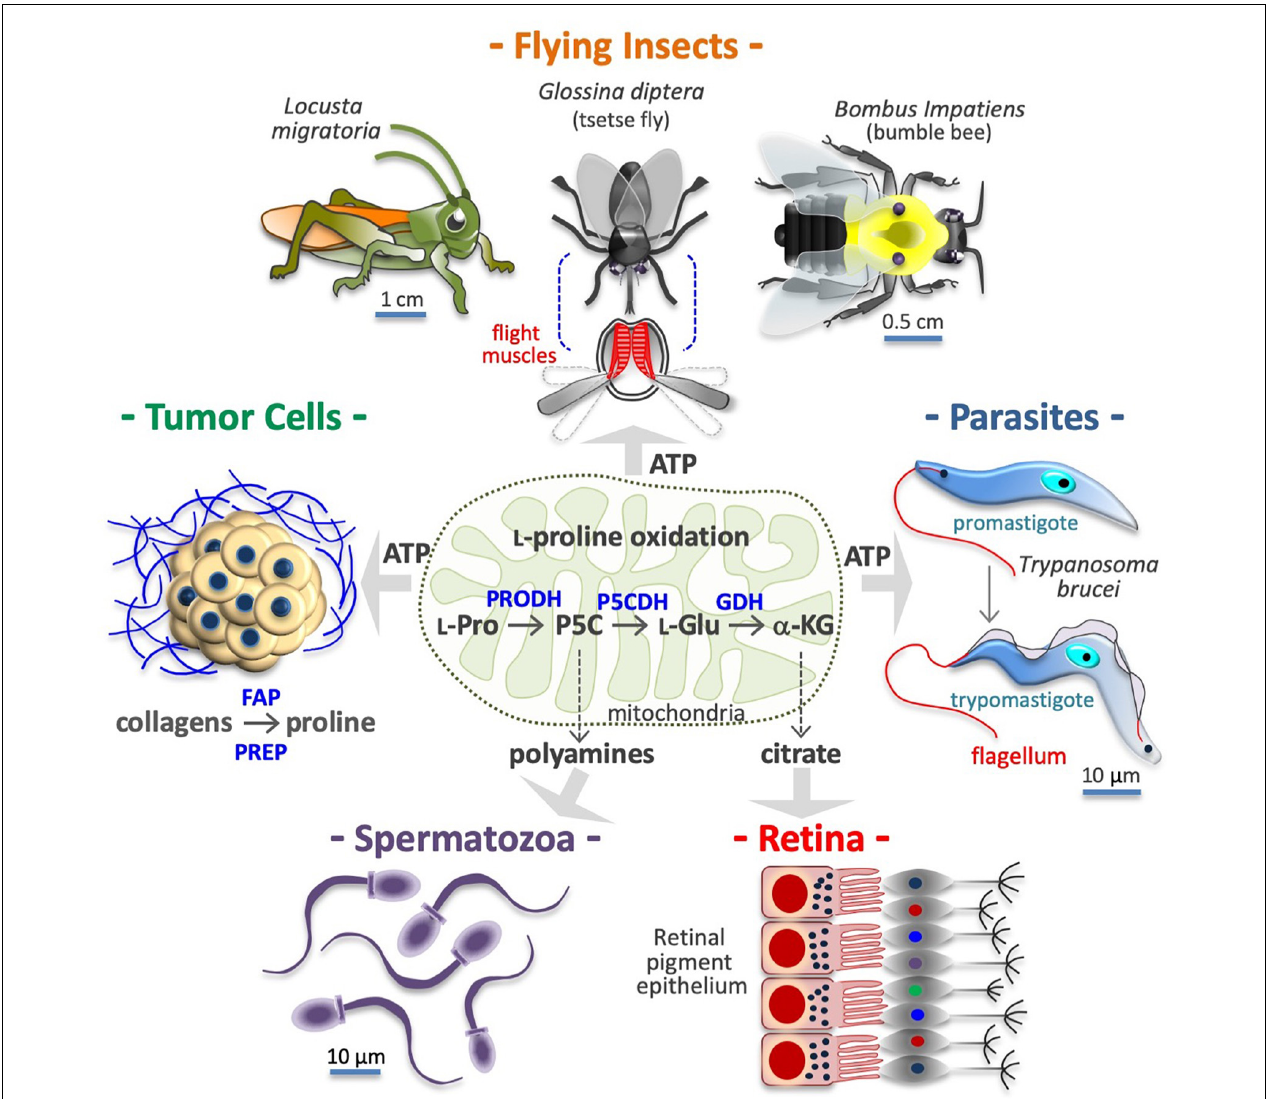
FIGURE 3 | Proline is a source of energy and metabolites. Many cell types obtain ATP/energy from mitochondrial oxidation of proline ( center ), including flight muscle cells of insects ( top ) , protozoan parasites ( middle right ) , and human cancer cells ( middle left ) . Other cells, including motile spermatozoa ( bottom left ) use the carbon skeleton of proline to produce polyamines via conversion into pyrroline-5-carboxylic acid (P5C) and ornithine. Lastly, retinal epithelial cells ( bottom right ) , produce citrate via conversion of L -proline into L -glutamate ( L -Glu) and α -ketoglutarate ( α -KG). In the tumor microenvironment, collagens degradation enzymes such as fibroblast activation protein (FAP), and prolyl endopeptidase PREP) release proline-rich peptides and free proline, which after internalization can serves to produce ATP and/or new collagens. Intramitochondrial enzymes involved in L -proline ( L -Pro) oxidation, namely proline dehydrogenase (PRODH) and the pyrroline-5-carboxylate dehydrogenase (P5CDH), and glutamate dehydrogenase (GDH), are indicated.